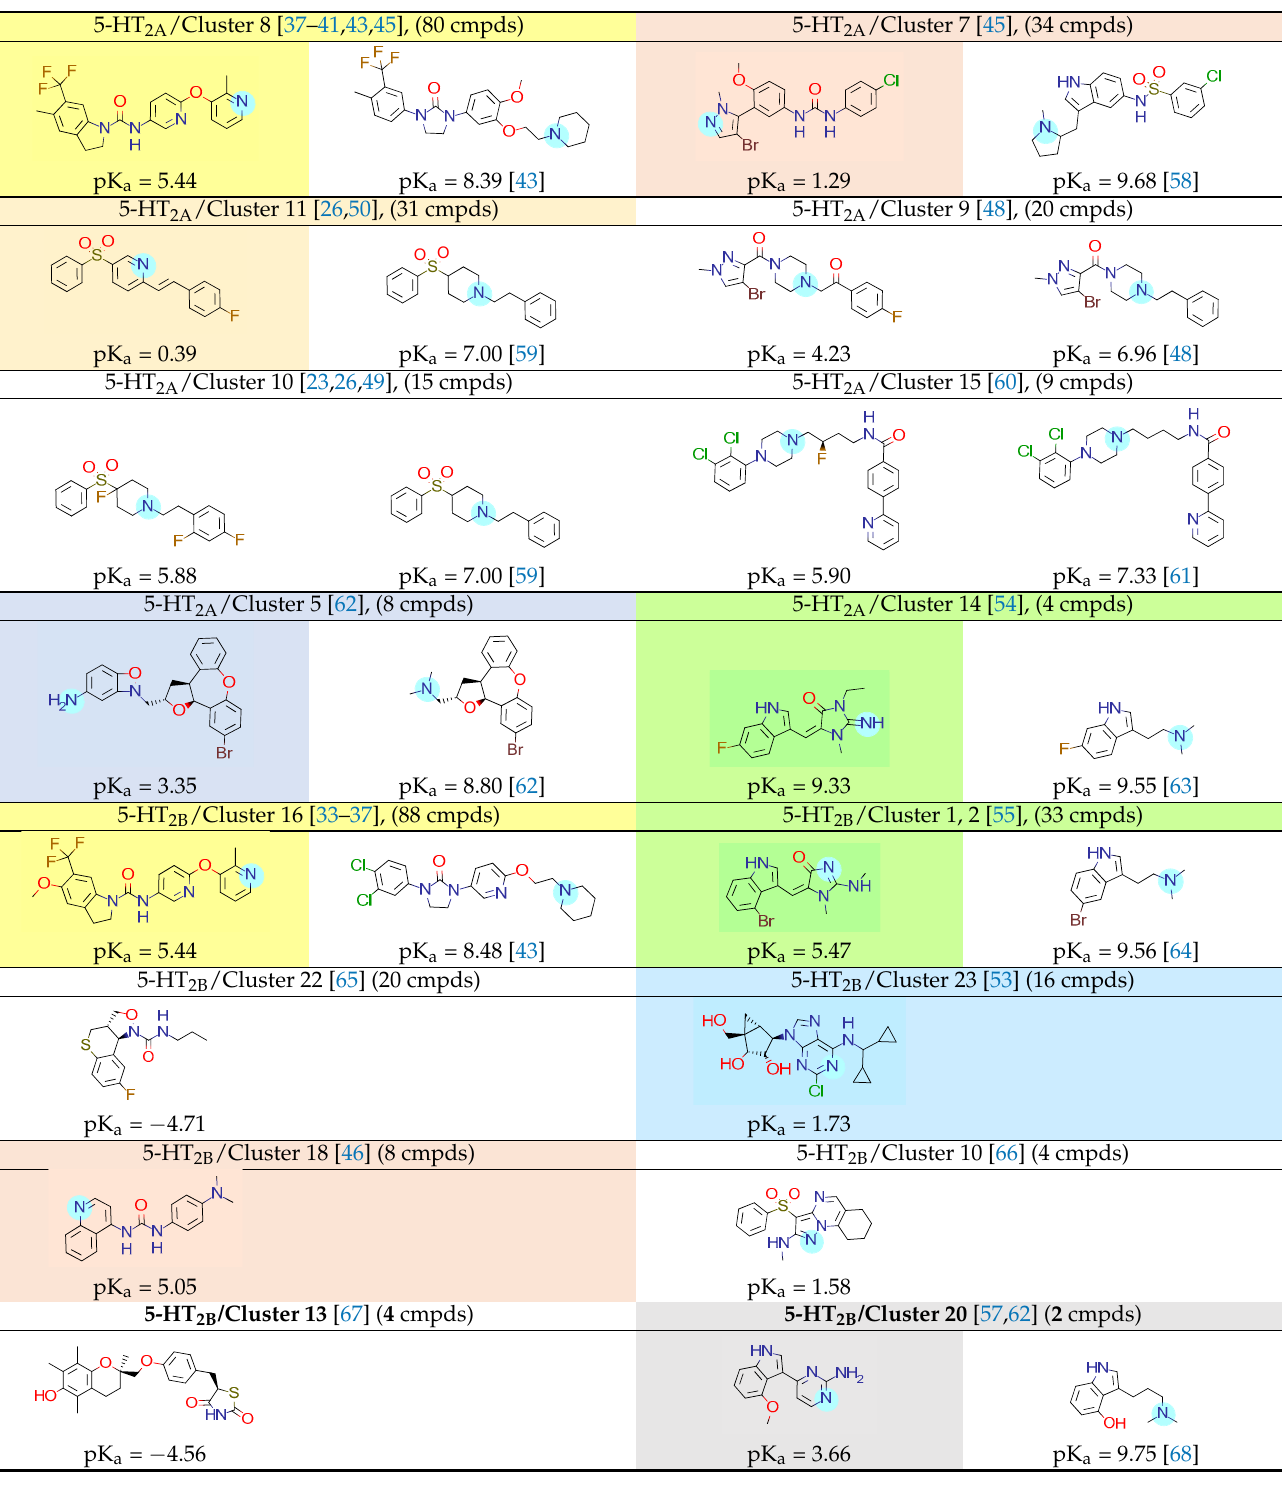
Table 1. Centroids of most populated clusters of nonbasic ligands of 5-HT 2A , 5-HT 2B , and 5-HT 2C receptors and their structurally related basic analogues. Compounds with overlapping cores for particular receptor subtypes share similar background color. The most basic part of each molecule is highlighted.